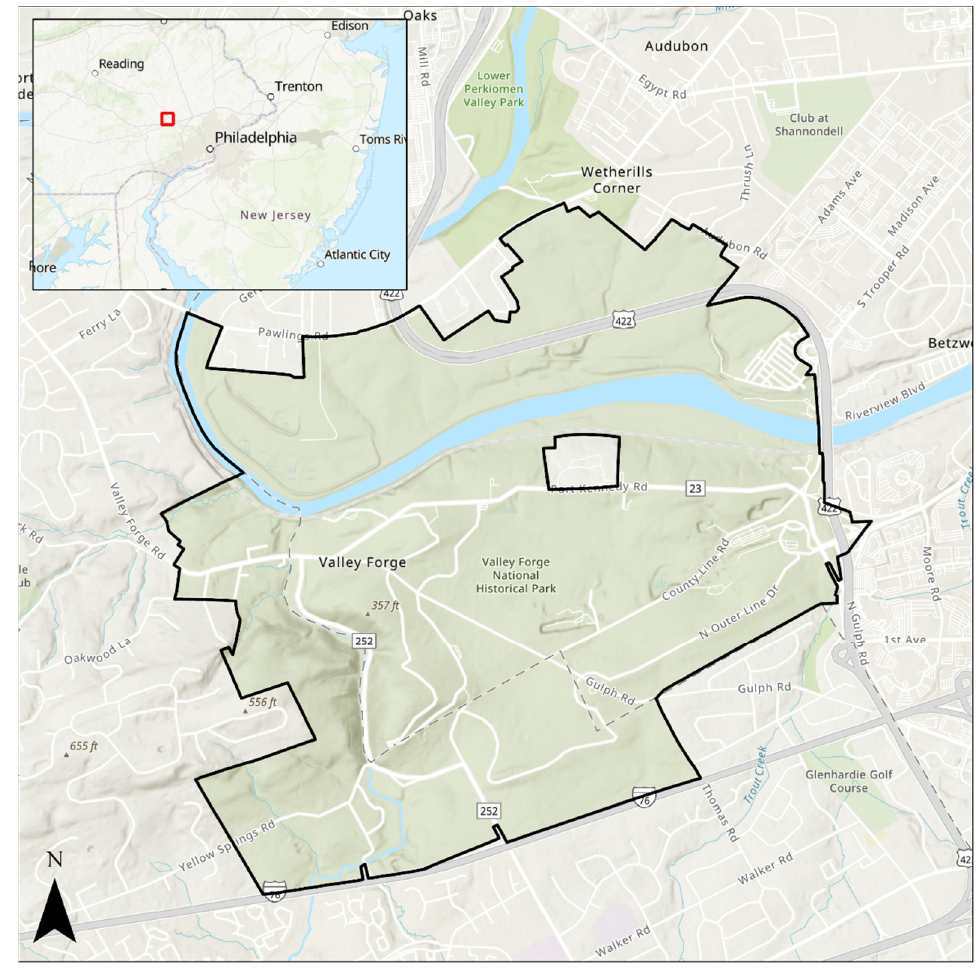
Figure 1. The 3500-acre Valley Forge National Historical Park (black outline) is located near Philadelphia, Pennsylvania, USA.